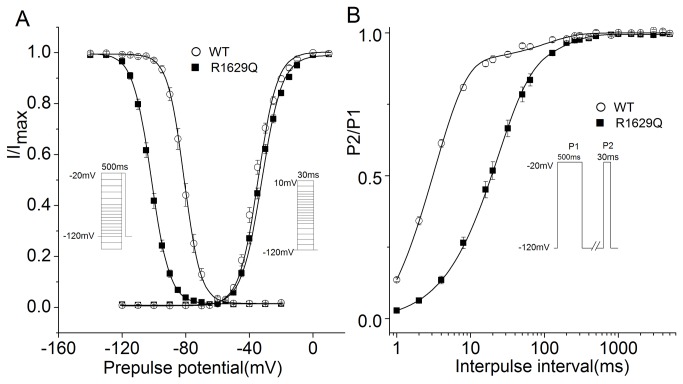
R1629Q alters Nav1.5 channel inactivation kinetics and prolongs the recovery time from inactivation.(A) Voltage dependence of steady-state activation and inactivation curve of WT (open circle) and R1629Q (filled square) channels. The protocol was shown in the Inset and Values for the half-maximal voltage (V1/2) were provided in the table 1. (B) Time courses of recovery from inactivation were investigated using the two-pulse protocol show in the inset. Time constants are as follows: WT, τf=3.2±0.2ms, τs=104.1±20.0ms,n=11;R1629Q,τf=22.5±1.0ms,τs=139.0±14.0ms,n=12.(Comparison of τf between groups is statistically significant. P<0.01).Results are presented as mean±SE.